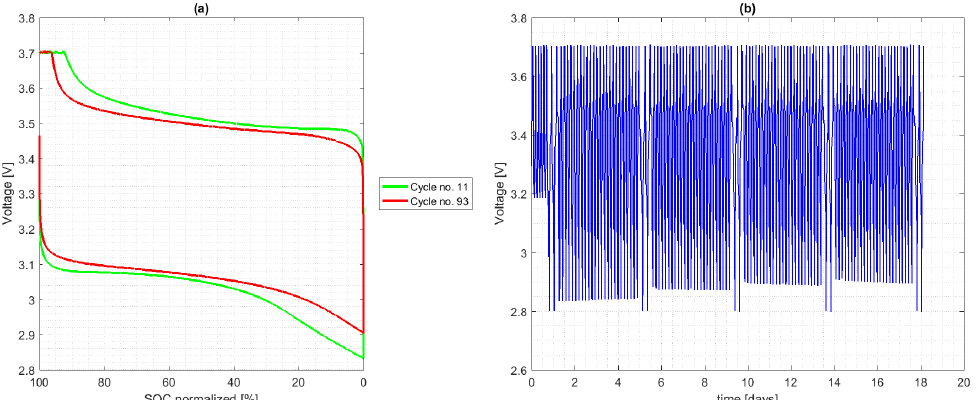
Figure 8. ( a ) Discharge and charge characteristics for sample C05s1 for cycles 11 (couple of cycles after the first capacity test) and 93 (couple of cycles after the last capacity before the last metacycle). ( b ) Gradual increase in end discharge voltage at the constant DoD over the